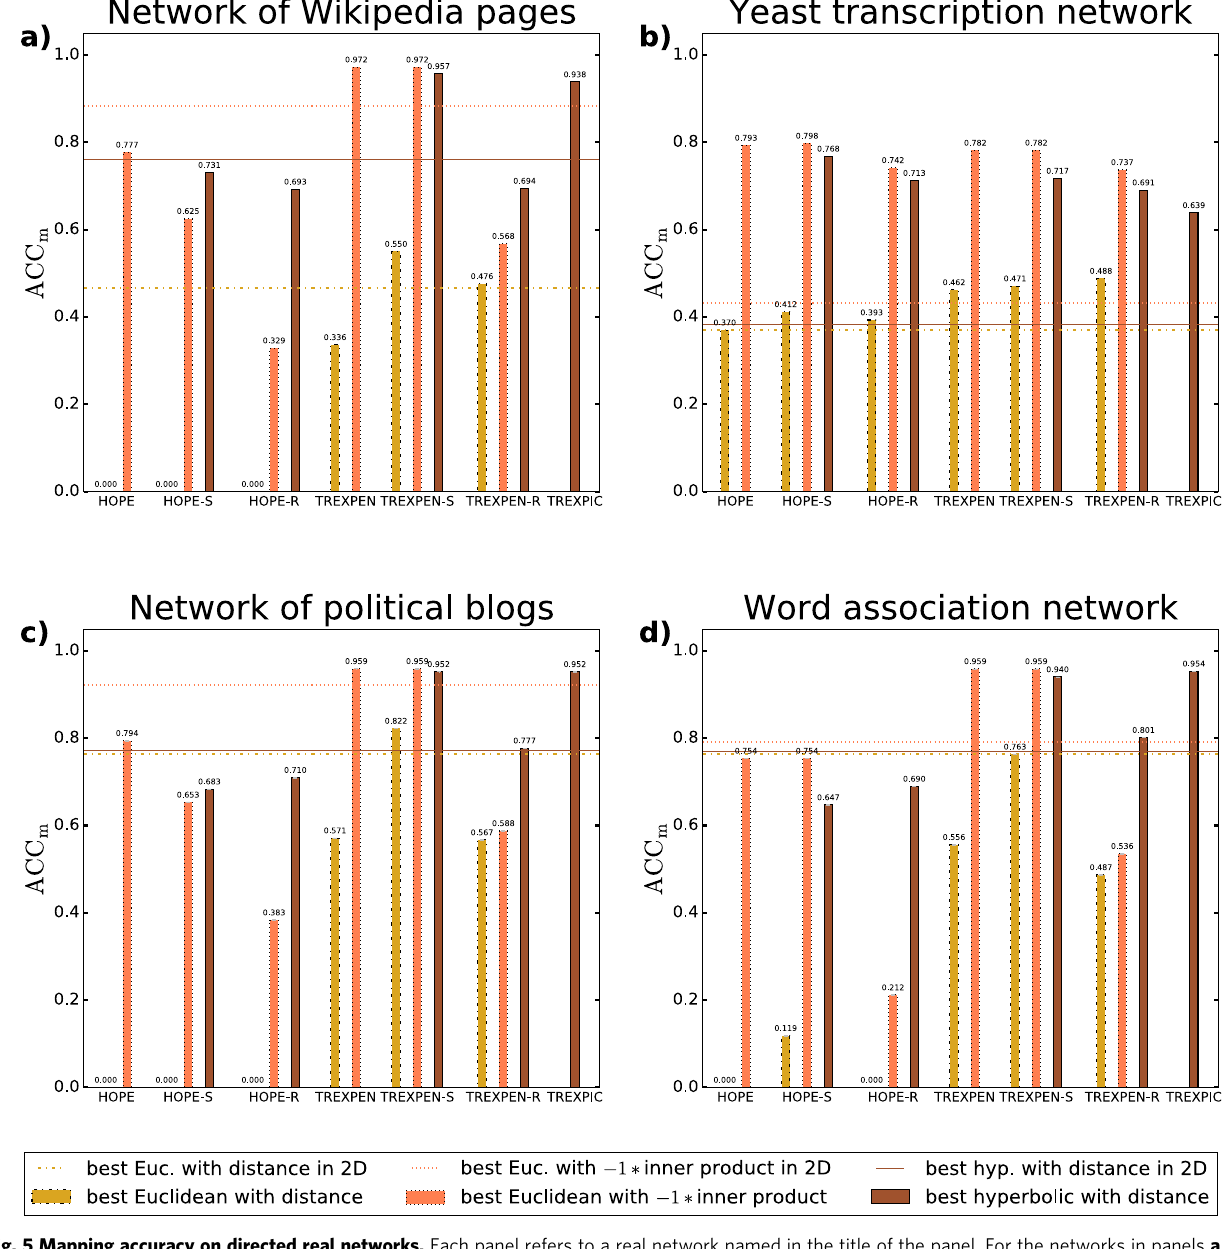
(Fig. 6h) the best method in the two-dimensional case is a